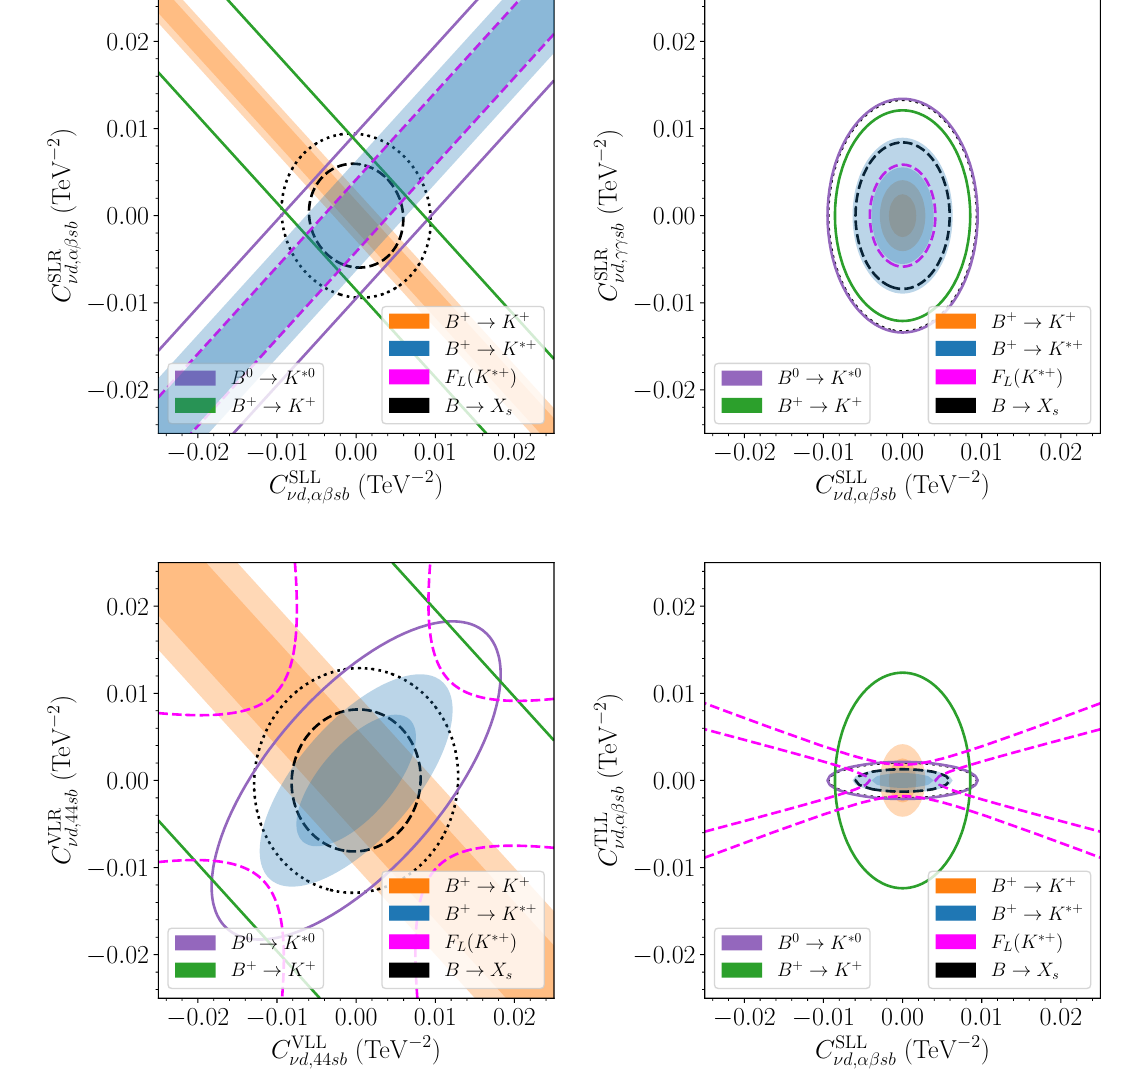
Figure 3 . Continuation of figure 2, but here the neutrino flavour indices are arbitrary with α 6 = β